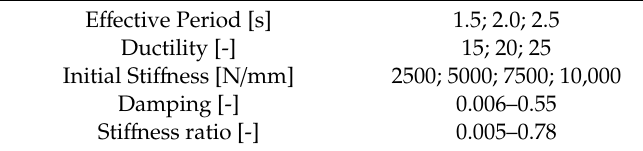
Table 3. Mechanical properties of the isolation system.